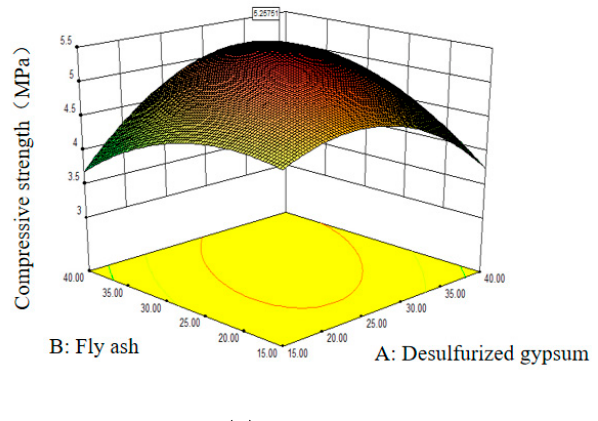
Figure 1. Compressive strength of MS1–MS15 samples.